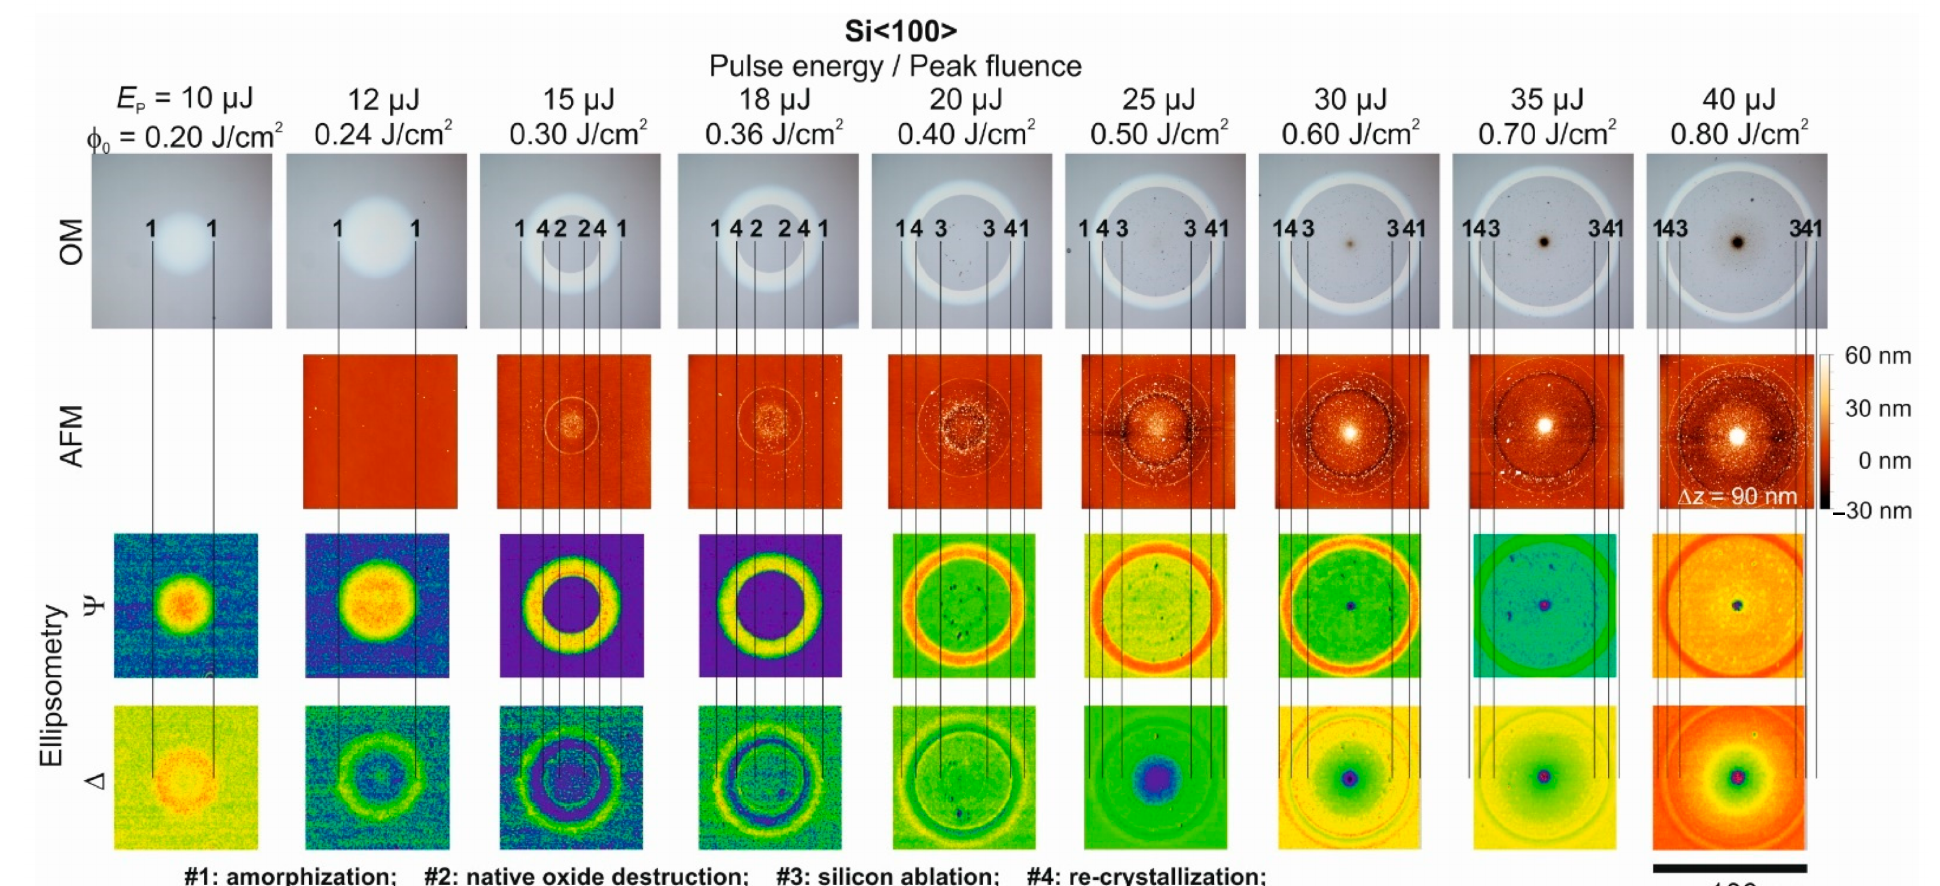
Figure 3. Comparison of brightfield optical microscopy (OM) images, atomic force microscopy (AFM) images, and corresponding spatial maps of the ellipsometric quantities Ψ and ∆ (taken at 637 nm wavelength) for a series of nine single fs-laser ( λ ~790 nm, τ = 30 fs) pulse-irradiated spots on a Si<100> wafer. The fs-laser pulse energy E p varies between 10 µ J and 40 µ J among the spots from left to right, corresponding to peak laser fluences between φ 0 = 0.20 and 0.80 J/cm 2 . The AFM images are provided in a common color scale, encoding height variations ∆ z of − 30 to +60 nm. The vertical (numbered) line sets mark the extent of characteristic surface features (for details see the text at the bottom of the figure). A common lateral scale bar is provided in the lower right